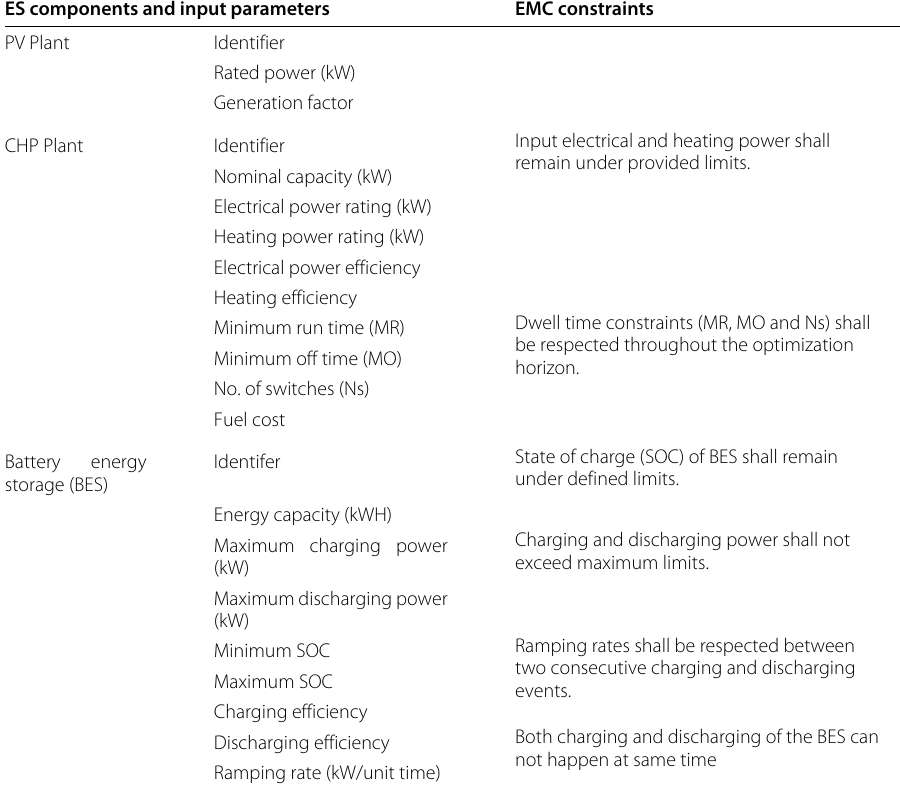
Table 5 Description of ES and constraints in the model